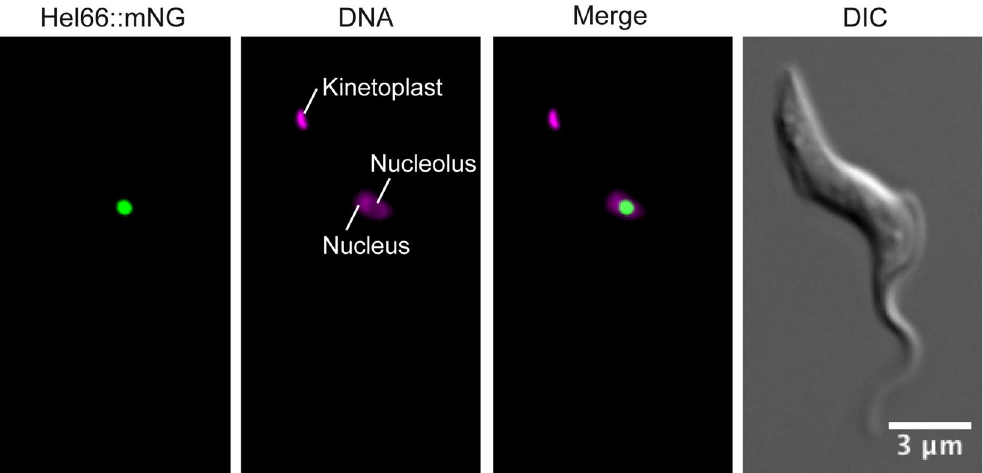
Figure 2. Localisation of Hel66 in BSF Trypanosoma brucei . Trypanosomes expressing endogenously tagged Hel66 (Hel66::mNeonGreen) were fixed and imaged. The mNeonGreen signal is concentrated in the nucleolus, the region of the nucleus with less intense DAPI stain. Note that in Kinetoplastida, DAPI also stains the name-giving kinetoplast, the DNA of the single mitochondrion. The images presented in this figure have been deconvolved, the raw images are shown in Supplementary Fig. S4.